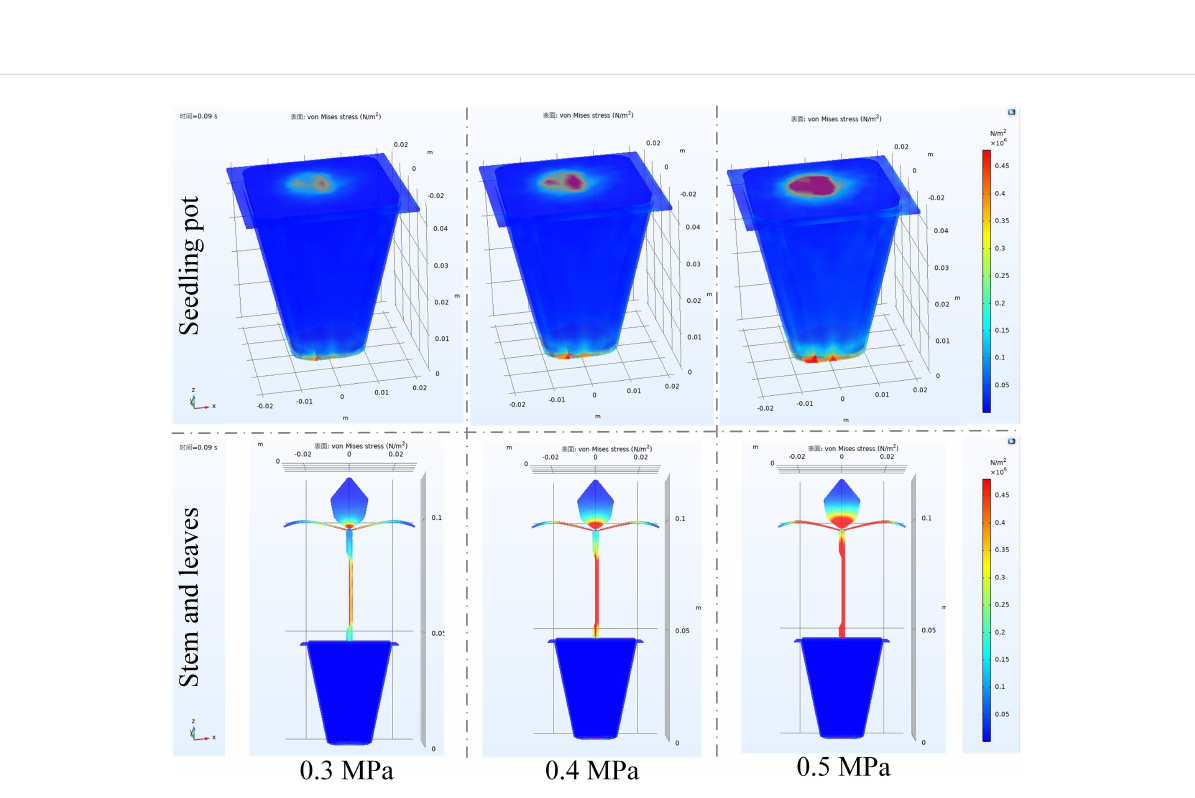
FIGURE 9 Stress analysis of seedling under different air fl ow pressures at 0.09s.